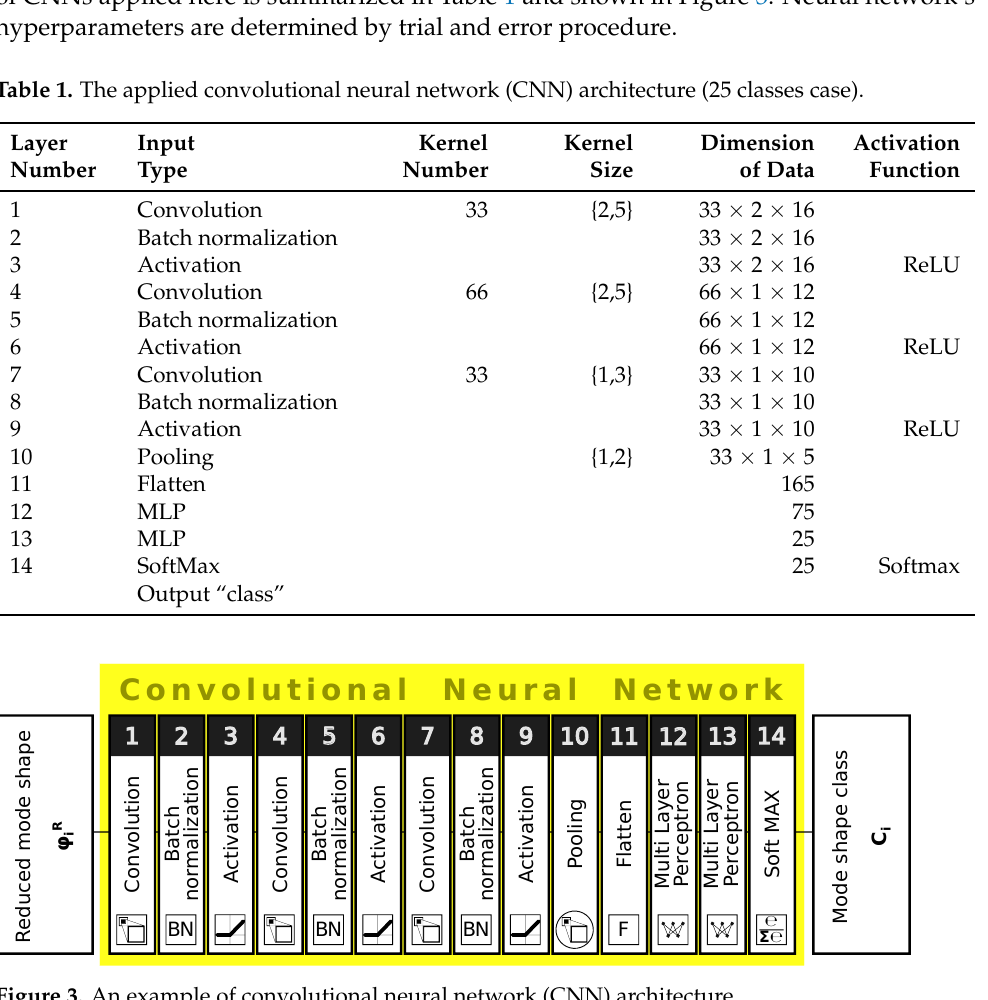
Figure 3. An example of convolutional neural network (CNN)